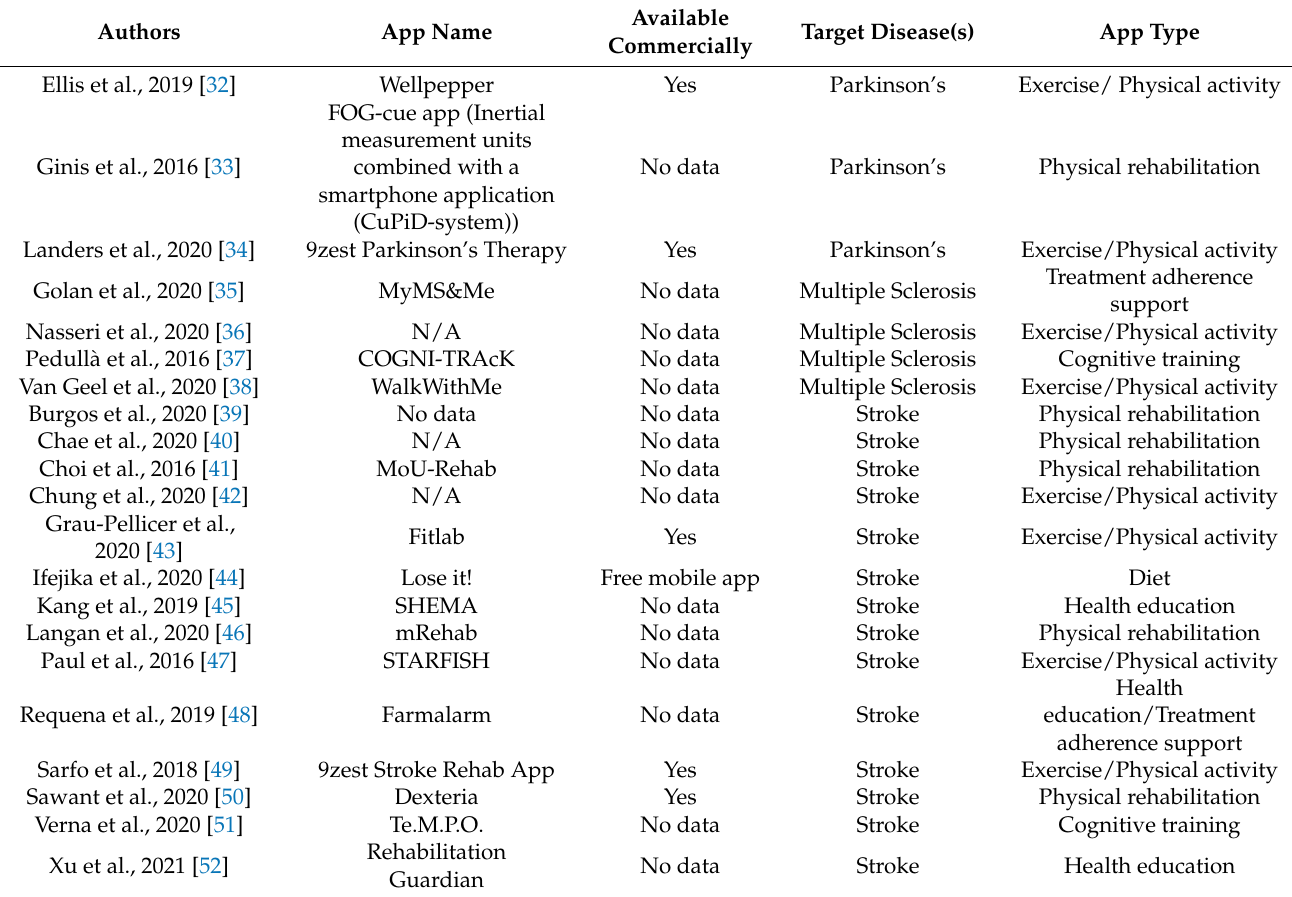
Table 2. Mobile app